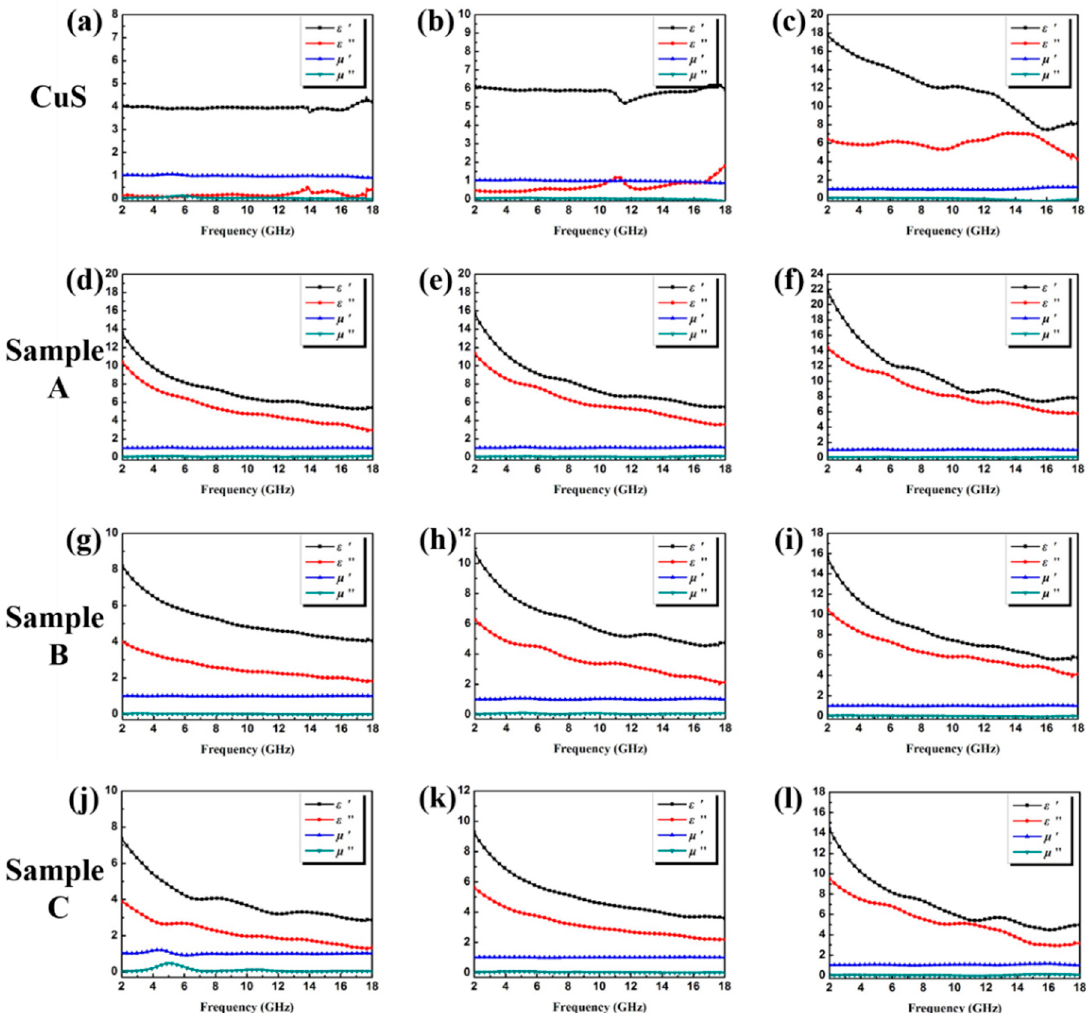
Figure 6. Frequency dependence of real and imaginary parts of complex permittivity and permeability of CuS with the filler loading of ( a ) 15 wt %, ( b ) 20 wt %, and ( c ) 30 wt %; Sample A with the filler loading of ( d ) 10 wt %, ( e ) 15 wt %, and ( f ) 20 wt %; Sample B with the filler loading of ( g ) 10 wt %, ( h ) 15 wt %, and ( i ) 20 wt %; Sample C with the filler loading of ( j ) 10 wt %, ( k ) 15 wt %, and ( l ) 20 wt %.